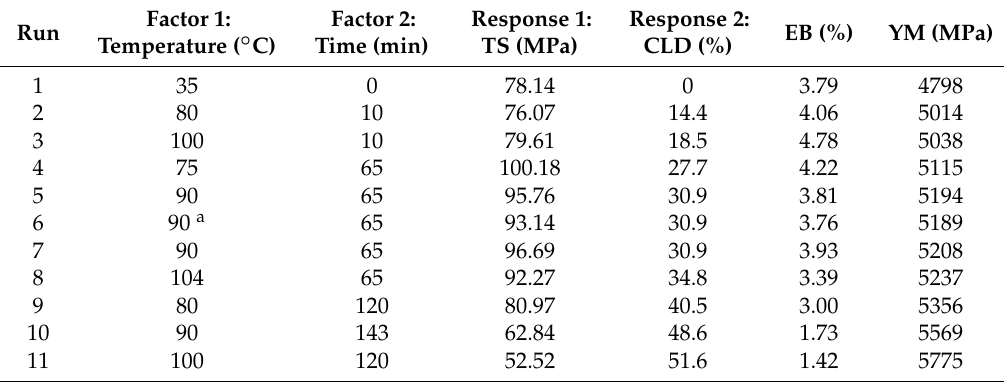
Table 1. Tensile strength (TS), cross-linking degree (CLD), elongation at break (EB), and Young’s modulus (YM) of chitosan films prepared at different curing times and temperatures.